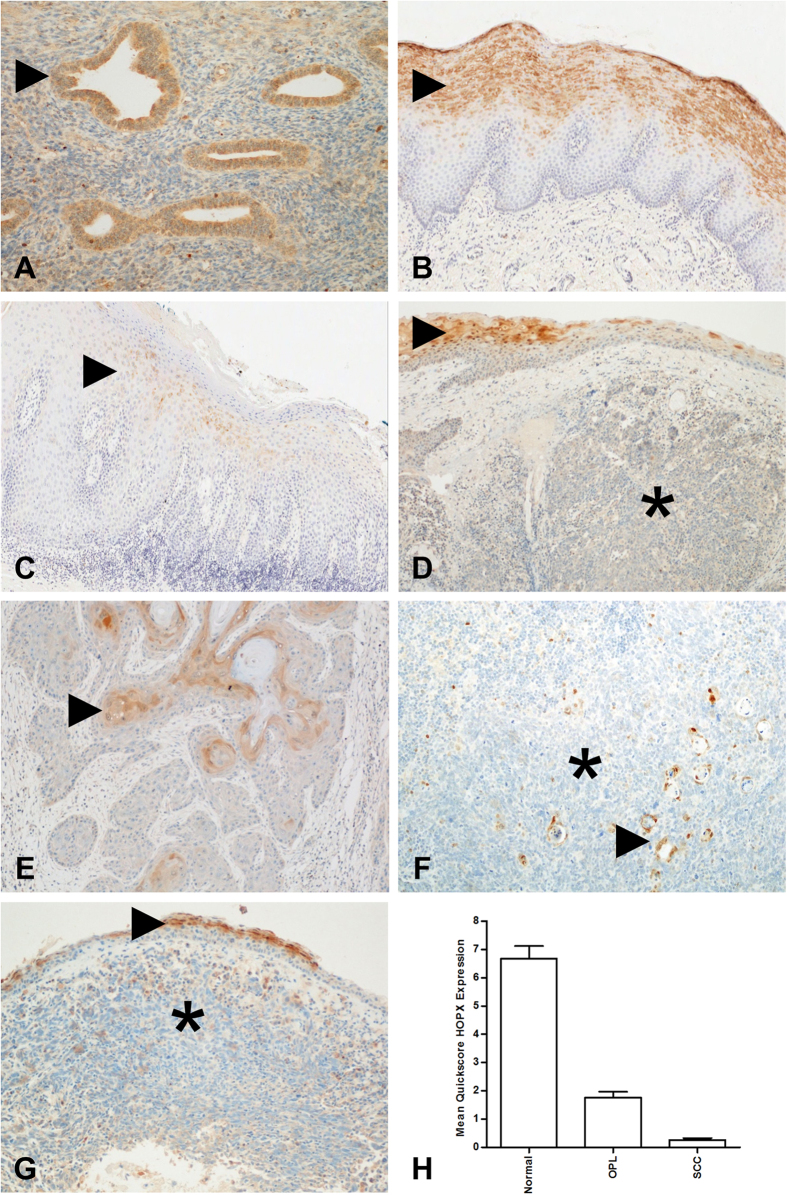
HOPX protein expression in HNSCCs by immunohistochemistry.The glands of secretory phase endometrium are known to express HOPX and were used as a positive control (A, arrowhead = gland). HOPX staining was strong in the keratinising layer of normal oral squamous epithelium (B,D and G, arrowhead = keratinising layer). By contrast, HOPX expression was reduced in oral premalignant lesions (C, arrowhead = keratinising layer). HOPX was absent in the majority of HNSCCs including OSCC, (D, * = malignant cells), OPSCC (F, * = malignant cells) and NPC (G, * = malignant cells). Focal HOPX staining co-localised with areas of keratinisation within tumours (E and F, arrowhead = keratinisation). Quantitation of HOPX expression using a quickscore method confirmed lower protein expression in premalignant lesions and OSCCs compared to normal oral squamous epithelium (H). Note: photomicrographs A, D-G HOPX Abcam ab57832, B and C HOPX Santa Cruz sc-30216. Experiment H used HOPX Santa Cruz sc-30216.